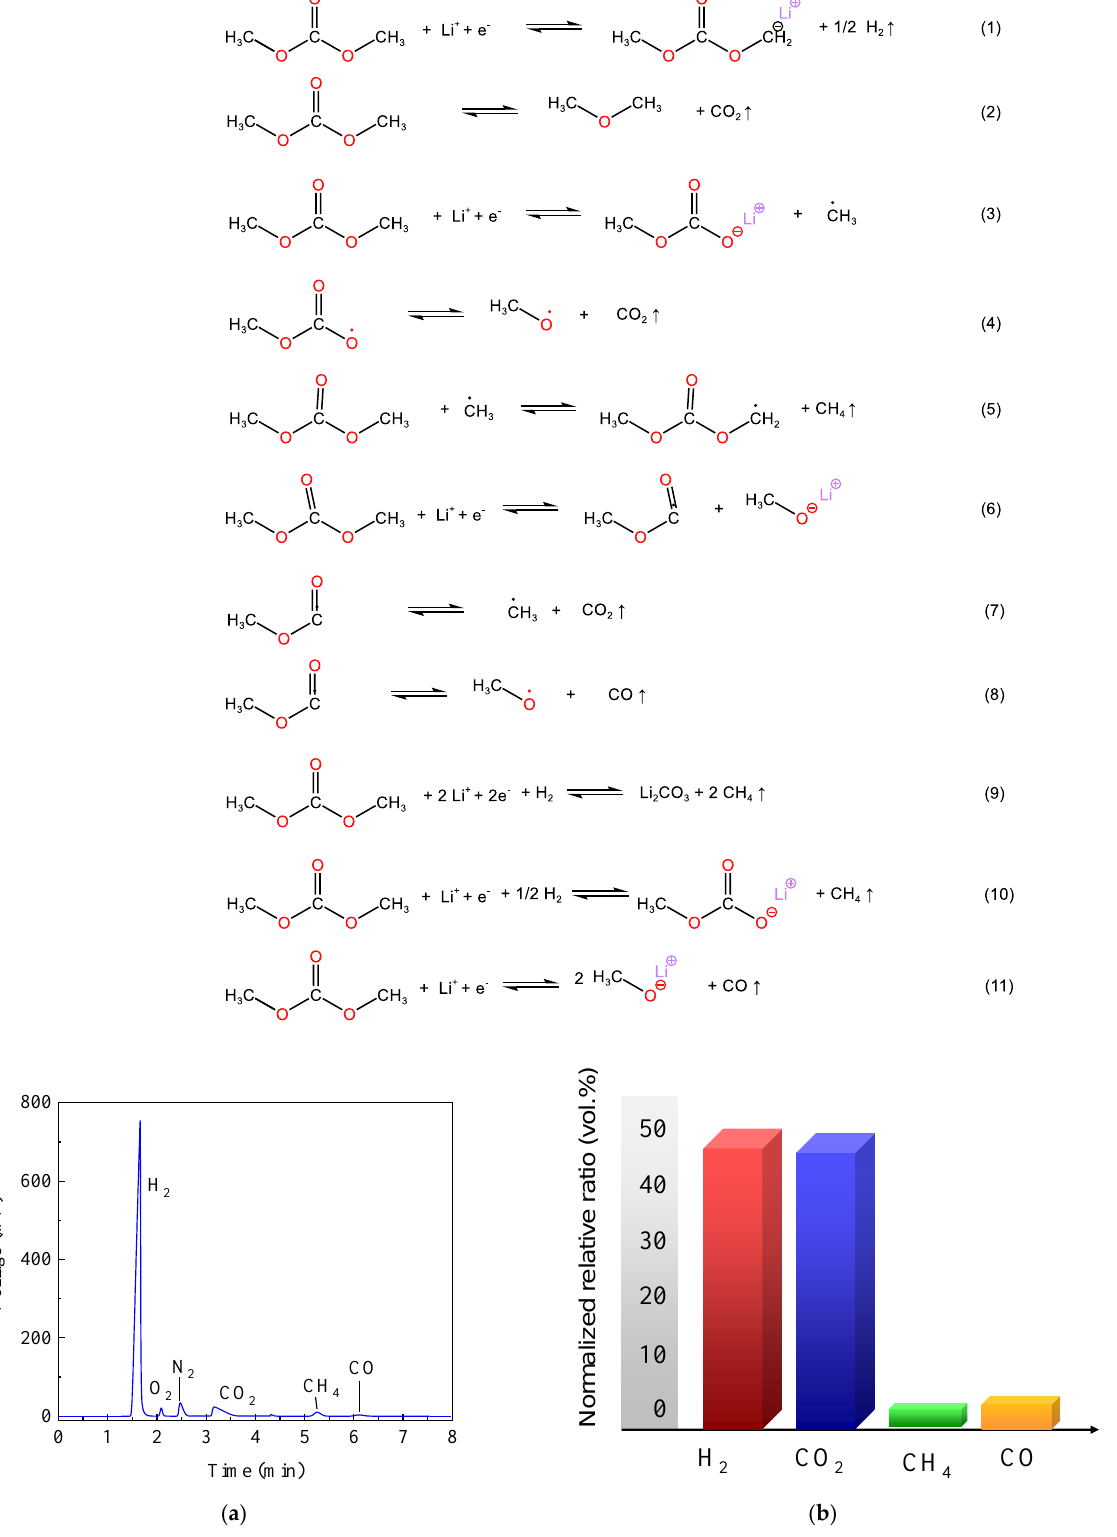
Figure 6. Identification and quantification of emitted gases: ( a ) gas chromatograph spectrum; ( b ) nor- malized relative volume ratio of the released gas